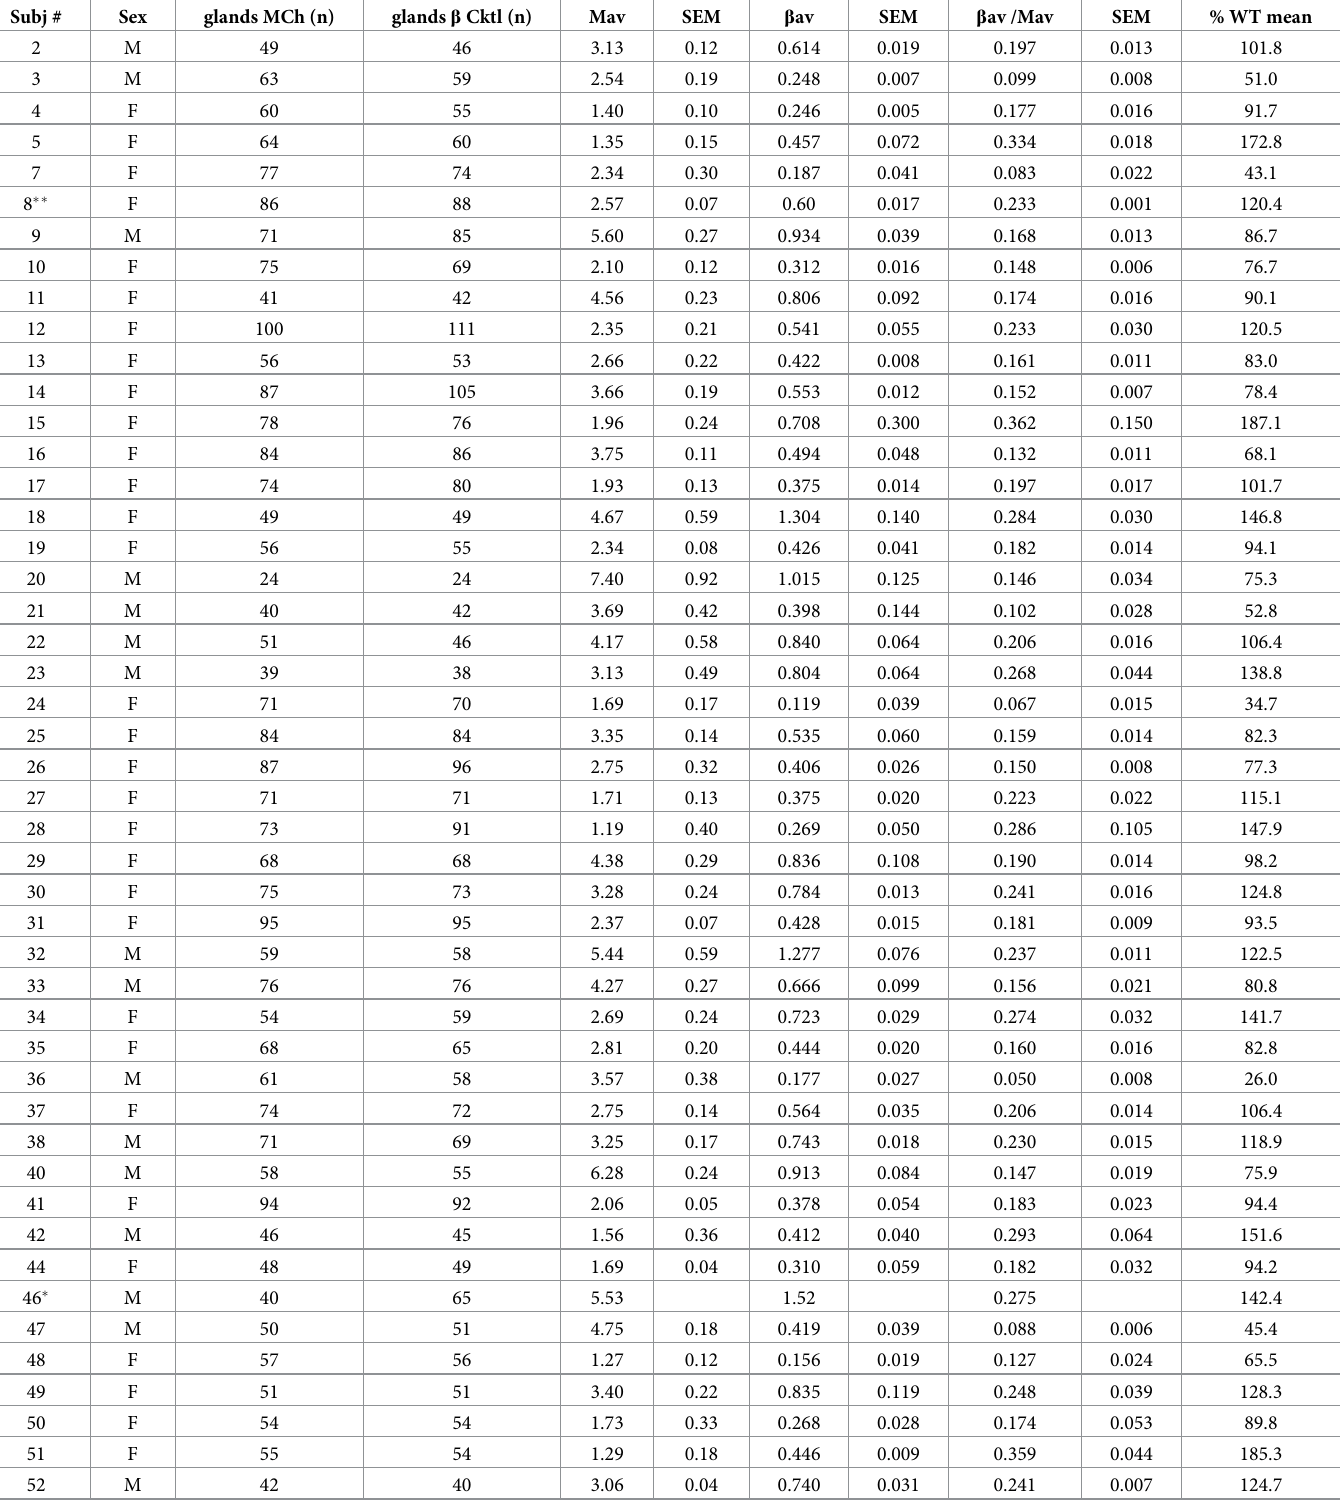
Table 1. Subject characteristics and summary data for subjects tested during assay